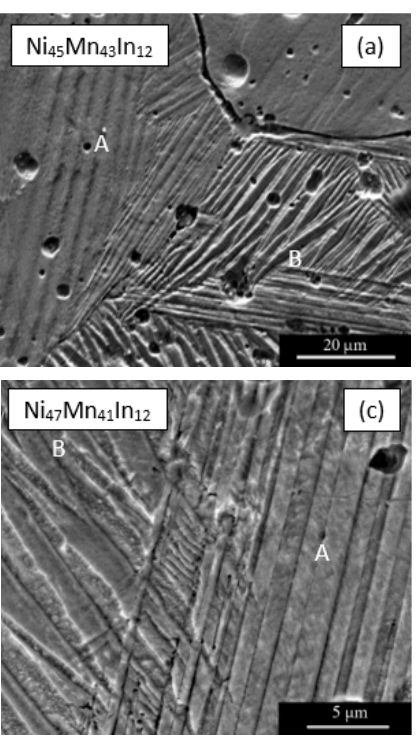
Figure 2. Electron microscopy images of the martensite structures in the alloys at room temperature: ( a ) Ni 45 Mn 43 In 12 , ( b ) Ni 46 Mn 42 In 12 , ( c ) Ni 47 Mn 41 In 12 . The letters A and B denote different morphological types of martensitic crystals. Table 2. Chemical analysis results of the Ni 47 − x Mn 41+x In 12 (x = 0; 1; 2) alloys. Alloy Content of Each Element,